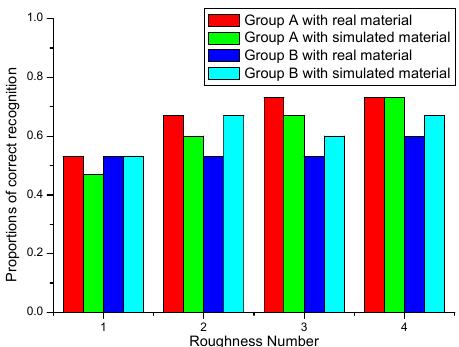
Figure 9. The proportions of correct recognition of two groups for real and simulated SS samples.